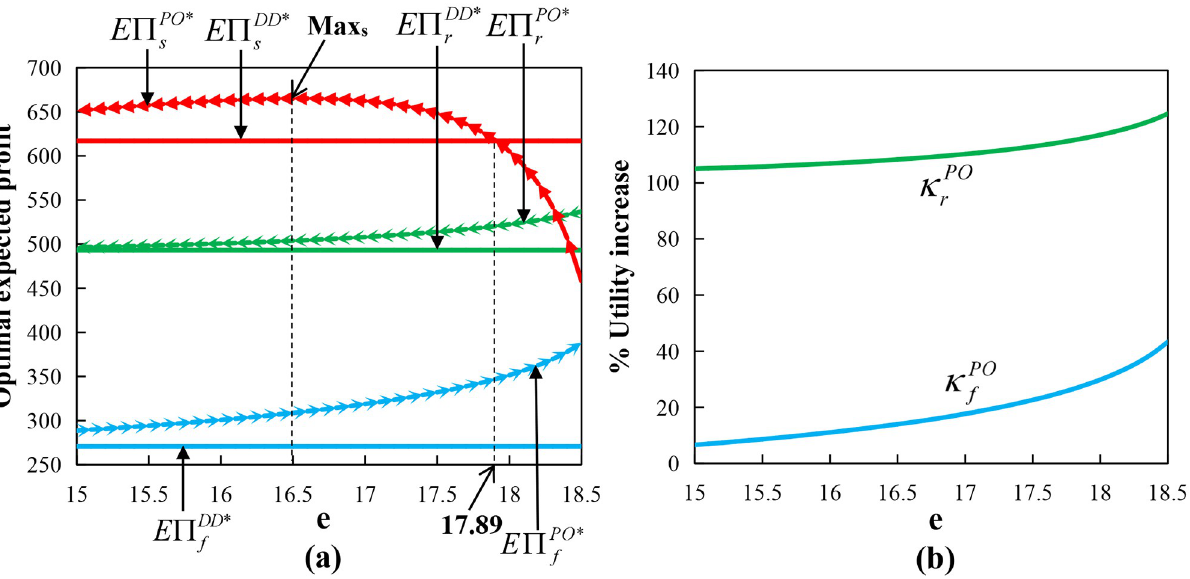
Fig 4. Impact of option exercise price under put option contract with wholesale price